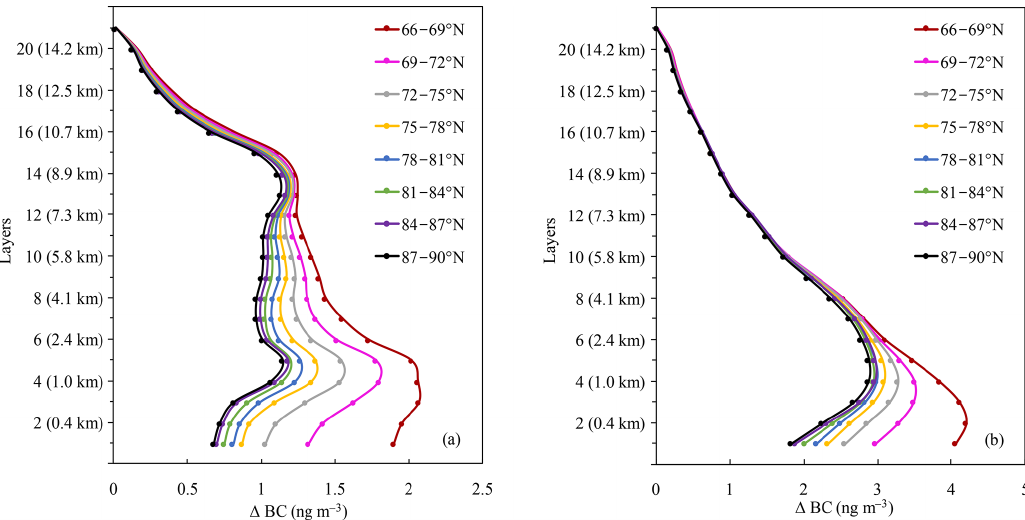
Figure 7. Contributions of 20% emission reductions from all six source regions to the vertical BC concentrations of the Arctic in different latitude bands vary with vertical layers in (a) summer and (b) winter in